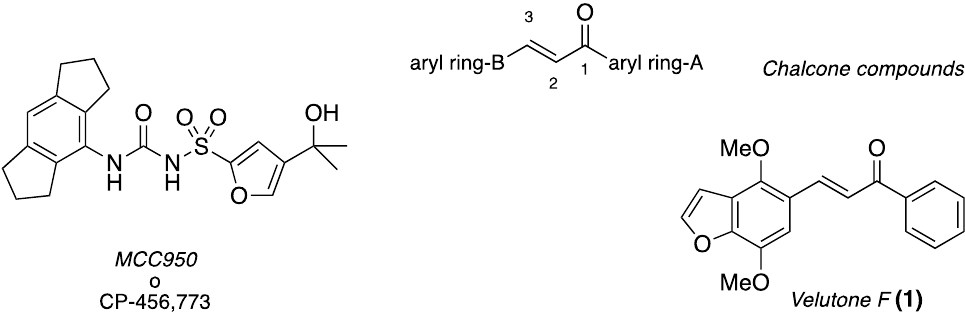
Figure 1. Natural and non-natural inhibitors of the NLRP3 inflammasome